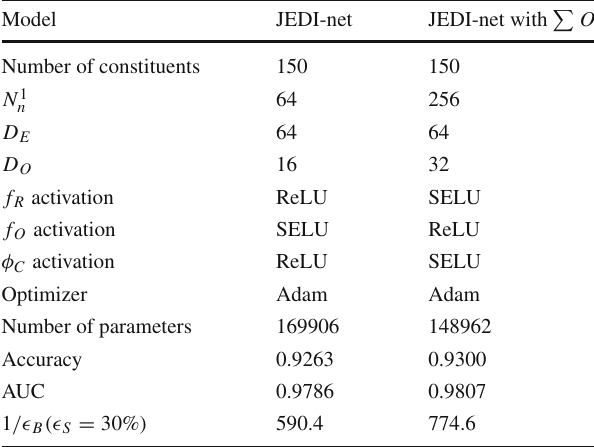
Table 7 The optimized hyperparameters, number of trainable parame-